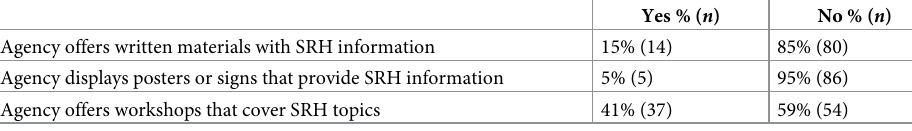
Table 2. Availability of SRH resources and education.